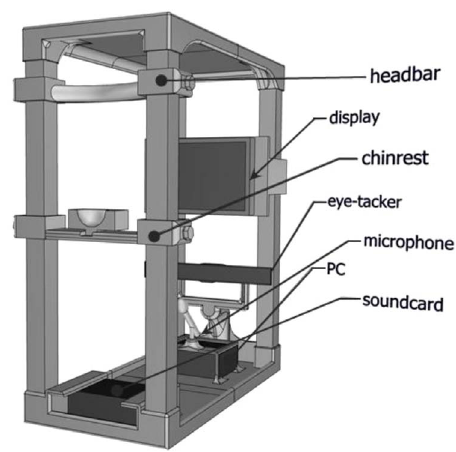
Figure 1. Schematic drawing of the MASAVE.